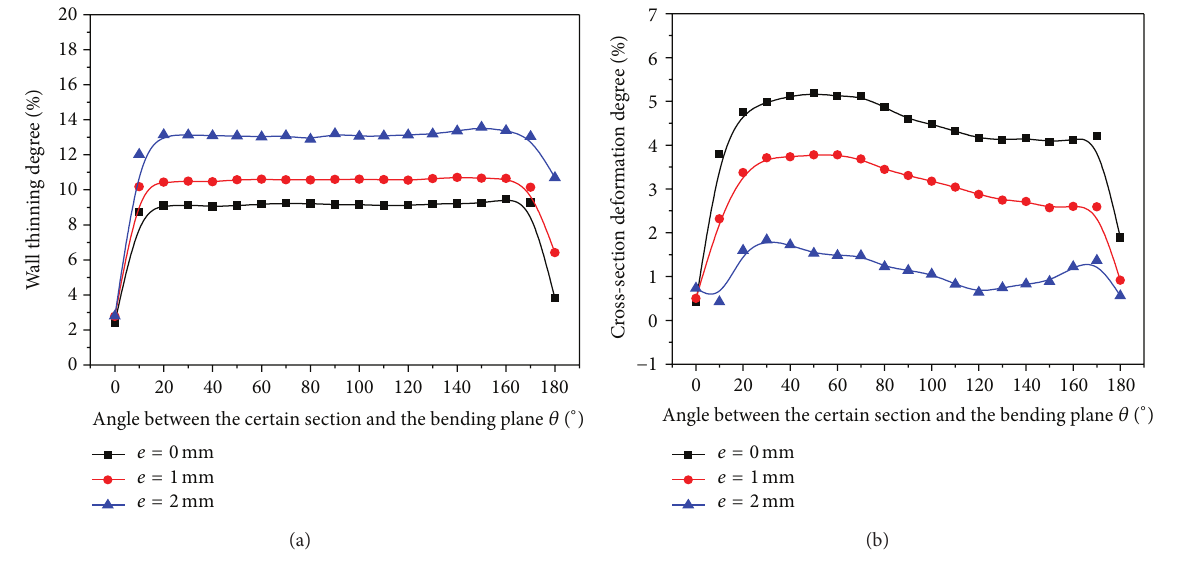
Figure 9: Effect of mandrel extension length on cross section quality: (a) wall thinning; (b) cross section deformation.